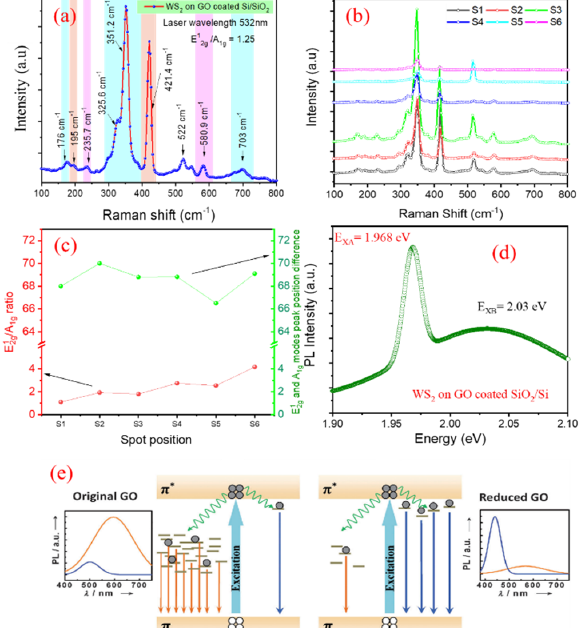
Figure 10. ( a ) Raman spectrum and ( b ) Raman spectra as a function of spot on different positions ( c ) Intensity ratio and difference of the peak as function of spot ( d ) Photoluminescence (PL) of WS 2 grown on GO coated Si/SiO 2 substrate, and ( e ) Evolution of PL spectra due to the transformation of sp 3 - to sp 2 -bonded region during the reduction of GO to RGO. Reproduced with permission from [67]. Copyright 2012